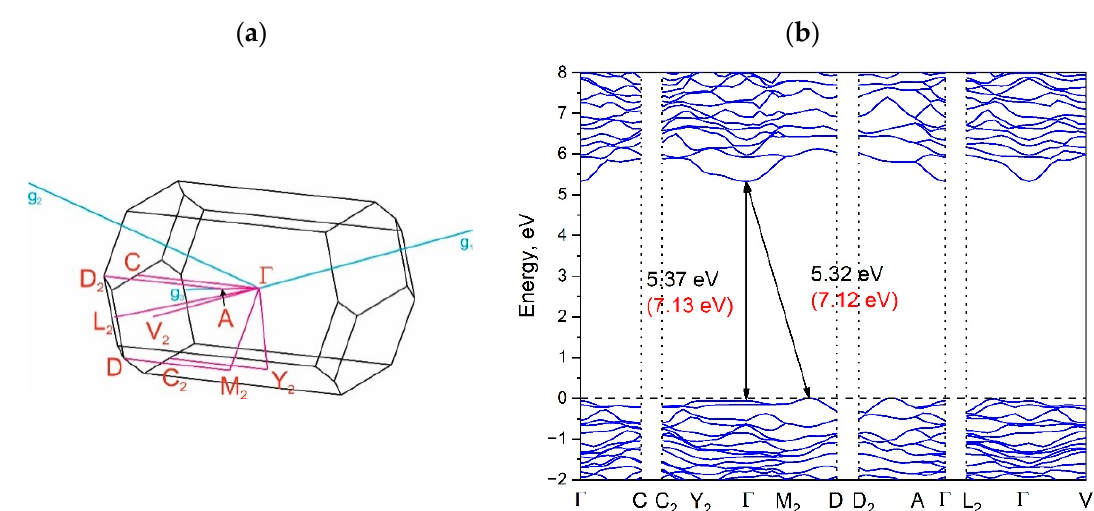
Figure 3. Brillouin zone ( a ) and electronic band structure ( b ) of Y 2 O 2 SO 4 . Band gap values obtained with the hybrid functional are shown in parentheses in ( b ).